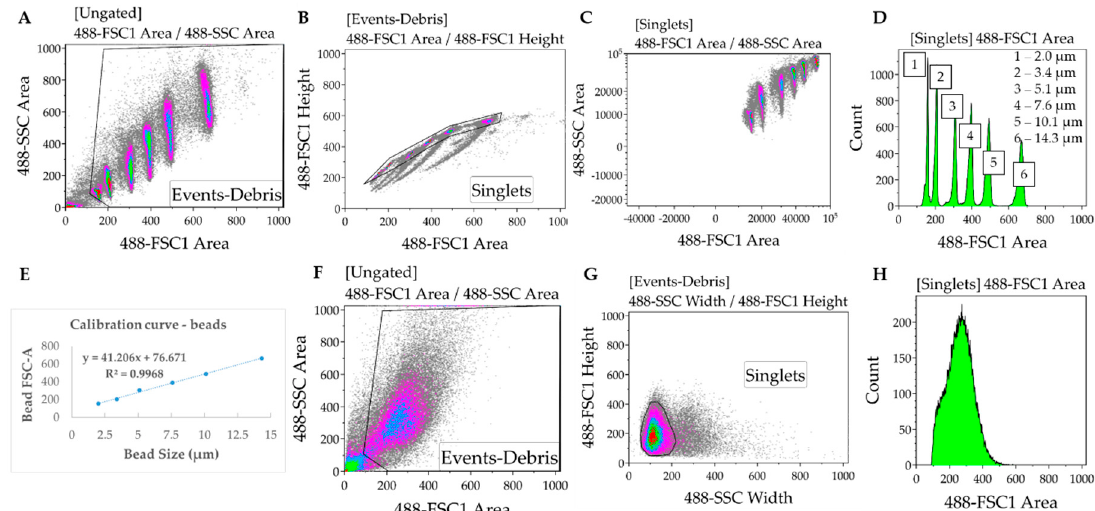
Figure 2. Protocol for evaluating hypertrophy by flow cytometry. ( A – C ) Forward (FSC) and side (SSC) scatter values of calibration beads of known sizes are measured, and debris and clumps are excluded by gating. ( D , E ) Each bead has a distinctive FSC value that is used to plot a calibration curve (FSC vs. size). ( F – H ) Cardiomyocyte samples are analysed and gated similarly to calibration beads to measure FSC values, which are used to determine cell volume.